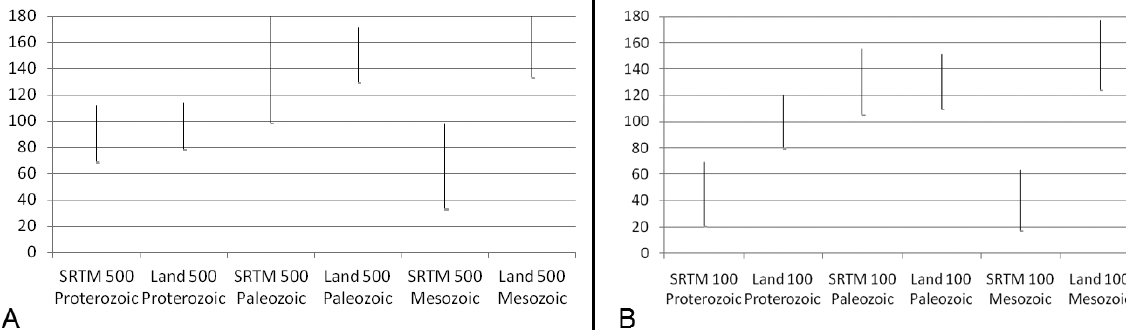
Figure 4 - Linear representation of the structures extracted from SRTM and LANDSAT at a 1:500,000 scale (A) and for 1:100,000 scale (B) for each geological domain, based on the mode and circular standard deviation. Value in ordinate axis represents azimute.